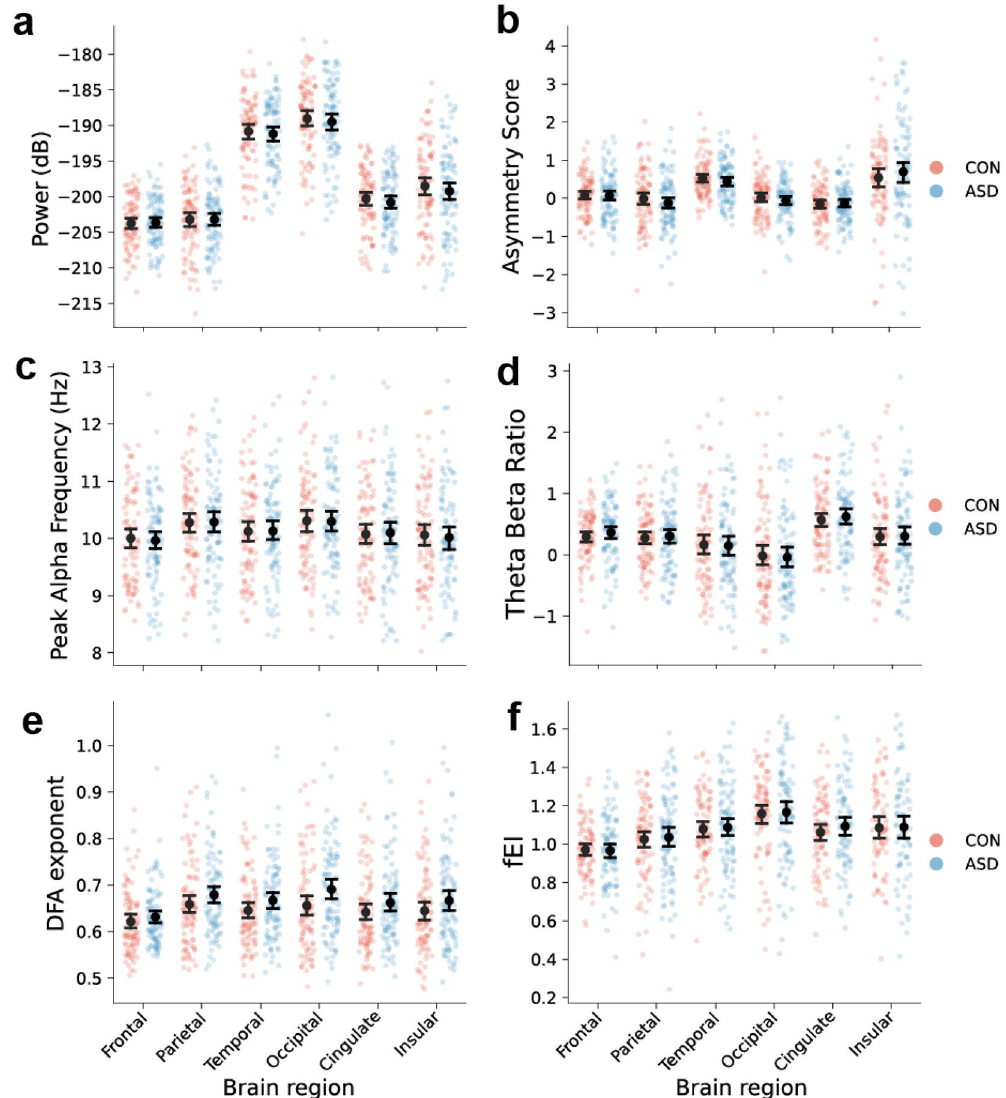
Figure 4. The ASD and non-autistic comparison groups have similar quantitative EEG features. Representative examples of computed EEG feature values averaged across the brain regions for: ( a ) Absolute Alpha Power, ( b ) Alpha Asymmetry, ( c ) Peak Alpha Frequency, ( d ) Theta/Beta Ratio, ( e ) Alpha DFA exponents, and ( f ) Alpha fEI. Mean with 95% confidence intervals are